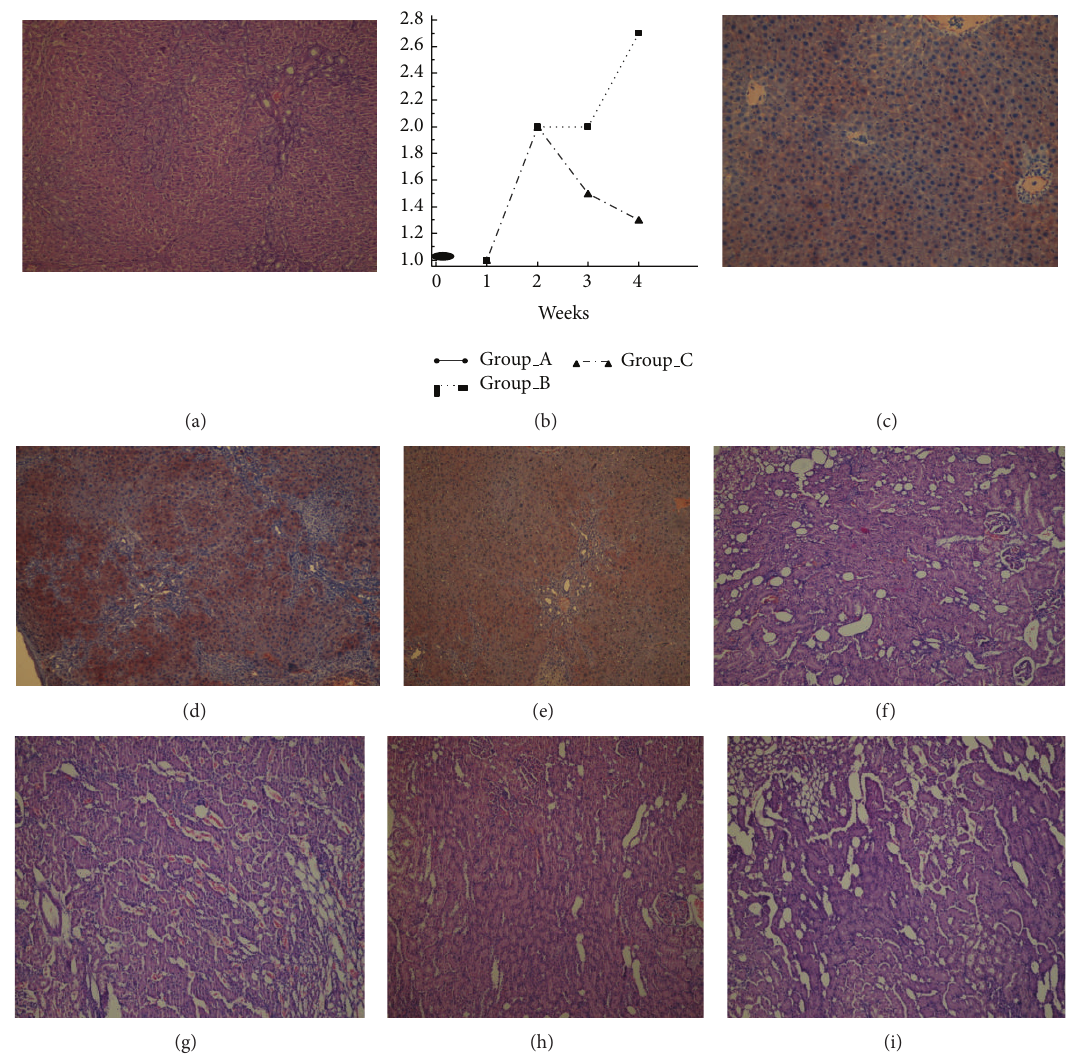
Figure 2: (a) (Group C): enlargement of the portal region and bridging fibrosis present in Group B. Enlargement of the portal region was present in Group C, but no bridging fibrosis was present (H&E, × 200). (b) Rat liver e-NOS expression for each week: no staining (0), low (1), moderate (2), and strong (3). (c) Weak cytoplasmic expression of e-NOS in hepatocytes (eNOS, × 200). (d) (Group B) and (e) (Group C): hepatocyte cytoplasmic expression of e-NOS was weaker in Group C than in Group B (eNOS, × 200). (f) (Group B) and (g) (Group C): the necrotic area in Group B was more intense than in Group C (H&E, × 200). (h) (Group B) and (i) (Group C): the necrotic area in Group B was more intense than in Group C (H&E, × 200).